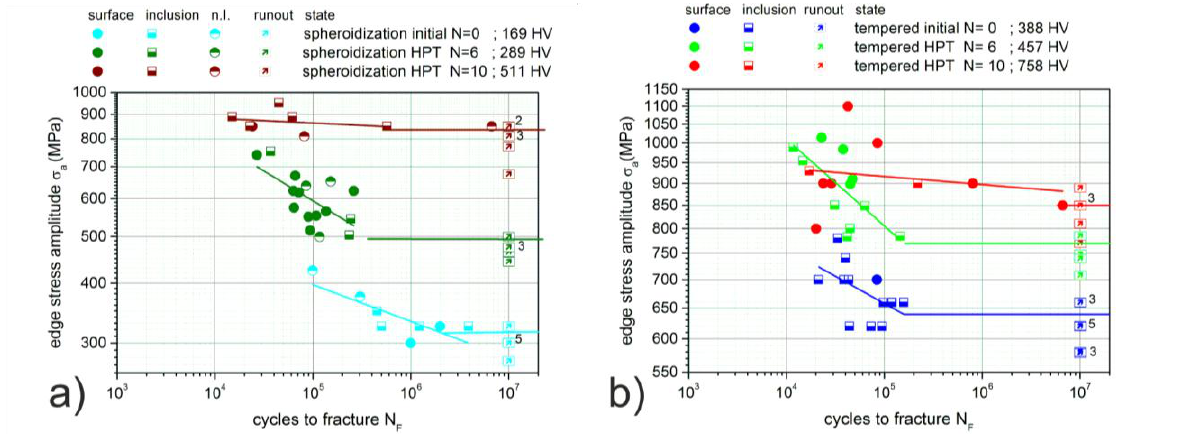
Figure 6. S-N curves of ( a ) CG and UFG spheroidized SAE 1045 revealing endurance limits of 316 MPa, 493 MPa and 837 MPa and of ( b ) UFG and CG tempered SAE 1045 showing endurance limits of 640 MPa, 769 MPa and 850